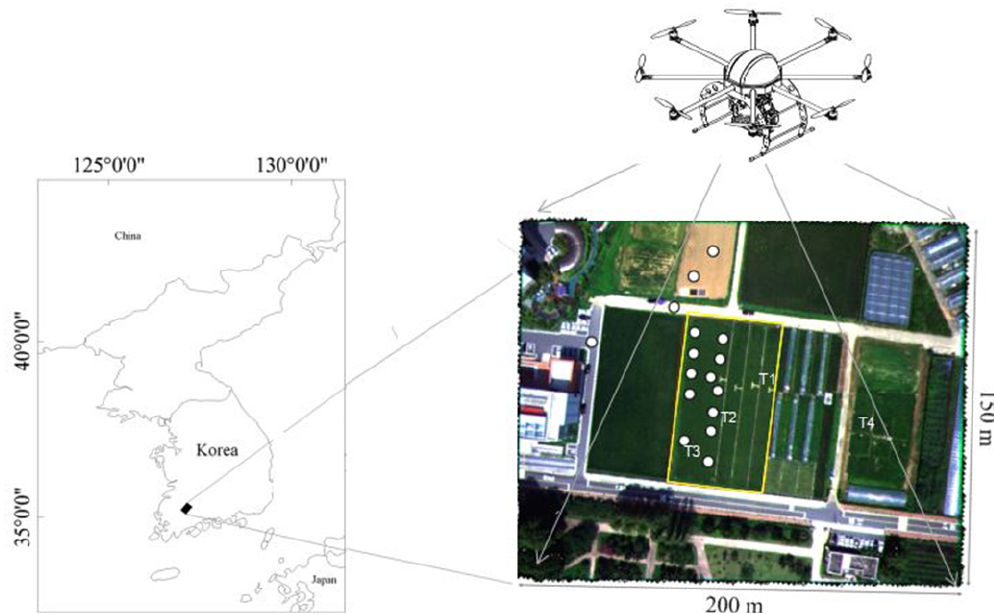
Figure 1. Illustration of the Gwangju study site where field data collection was carried out. Yellow square and white circles represent sites of paddy fields and those marked for measurements of ground reflectance by one handheld miltispectral radiometer (MSR) to validate UAV imagery. T1: PD rice under low-nutrient conditions (no supplementary nitrogen applied); T2: PD rice under high-nutrient conditions